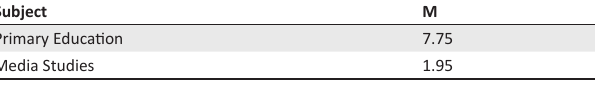
TABLE 3: Summary of results of t -tests for use of reporting verbs in Primary Education and Media Studies